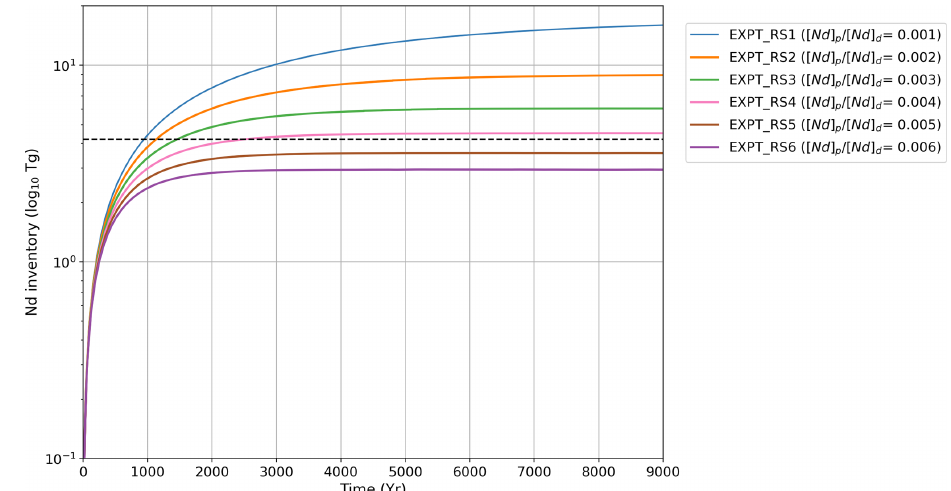
Figure 9. Global Nd inventory (g) simulated with different values for the reversible scavenging tuning parameter, [ Nd ] p / [ Nd ] d , as indicated. Dashed line represents the estimated global marine Nd inventory of 4.2 × 10 12 g by Tachikawa et al. (2003) used as a first-order target for our